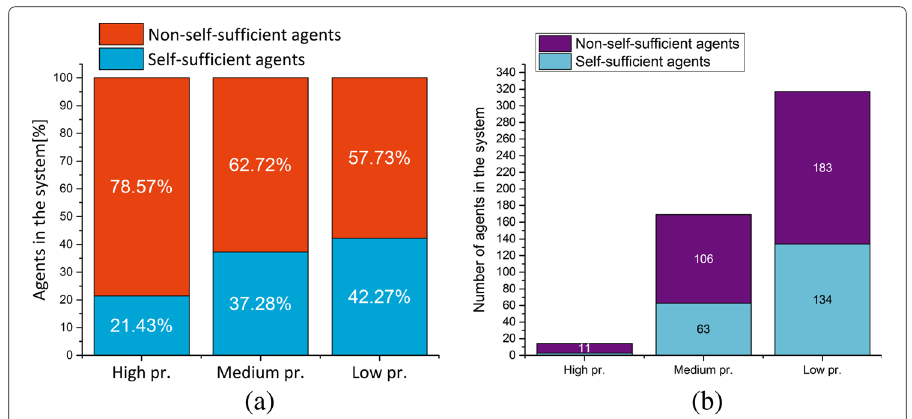
40% are prosumers with solar panels, 0.2% wind turbines (thus, 1 wind turbine), and 59.8% consumers. In the rest of this paper, the wind turbine is referred to as a producer . Wind production is calculated as in (Patel 1999), using Dutch wind speed, temperature, and air pressure data (Koninklijk Nederlands Meteorologisch Instituut.). The load and production profiles for this setup are shown in Fig.